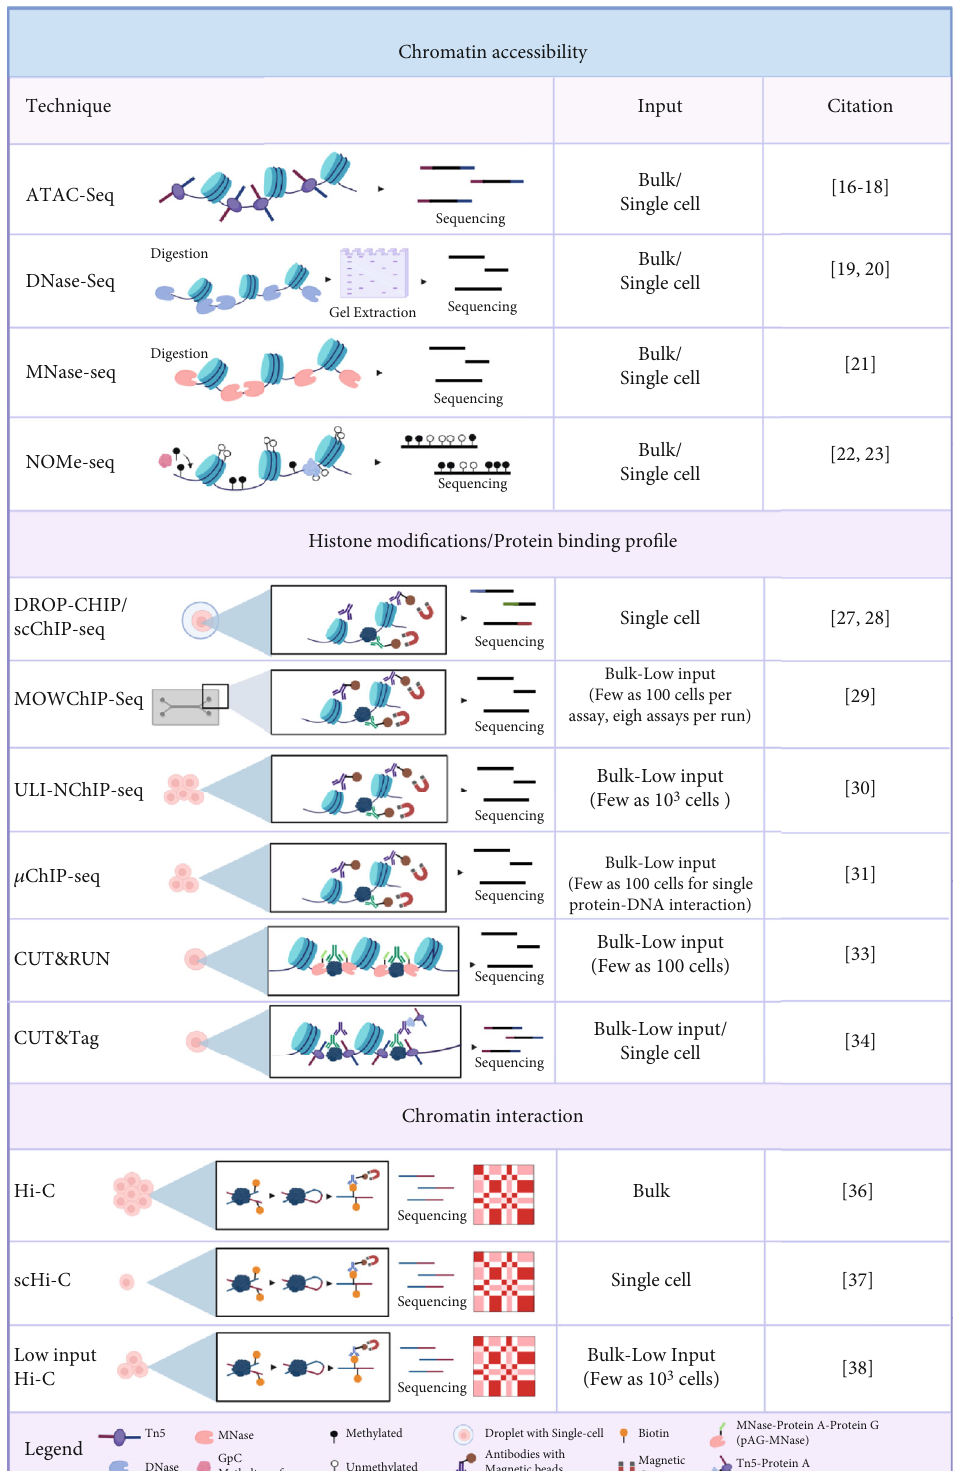
Figure 1: Summary of the comparison of di ff erent single-cell and low-input techniques to assess chromatin structure [16 – 23, 27 – 31, 33, 34, 36 – 38]. Created with